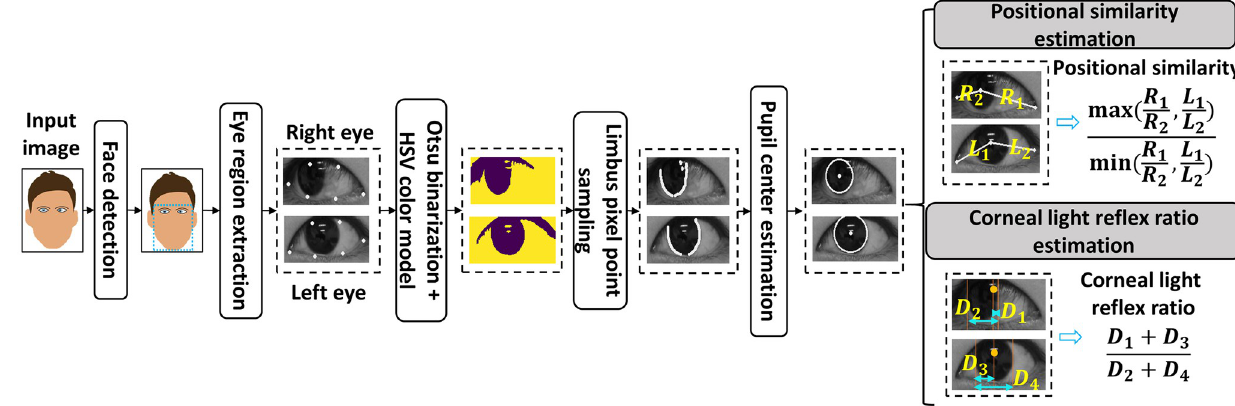
Fig 4. Image processing procedure on the eye region. R 1 , R 2 and L 1 , L 2 are the distance between estimated pupil centers and landmarks of the medial and lateral canthus on the right and left eye. D 1 and D 3 are the distances from the corneal reflex centers (orange dots) to the medial corneal limbus, D 2 and D 4 are the diameters of the